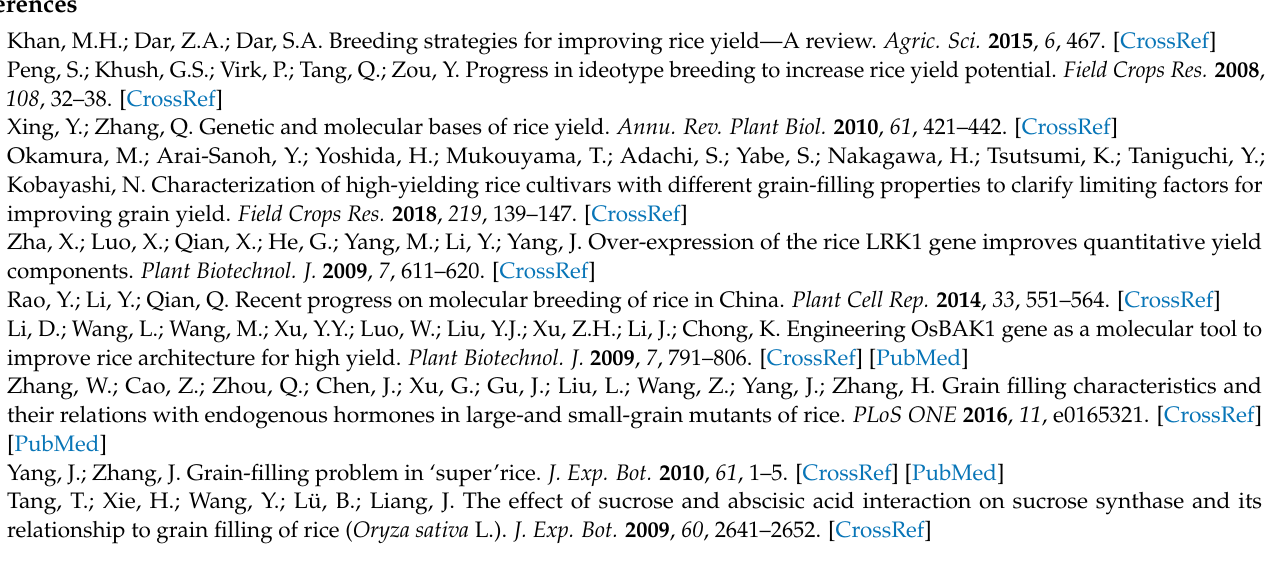
markers.; Table S3: Information on the physical distance between SNP markers.; Table S4: Distribution of flowering time of DH population according to the genotype of qFG3 .; Table S5: List of candidate genes; Table S6: Putative candidate genes located within qFG3